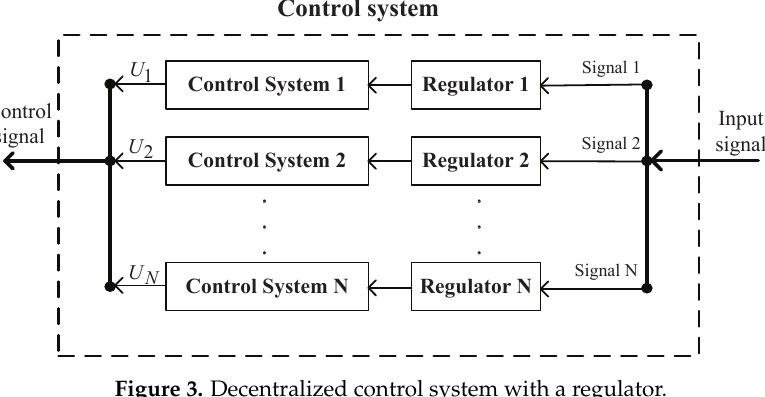
Figure 3. Decentralized control system with a